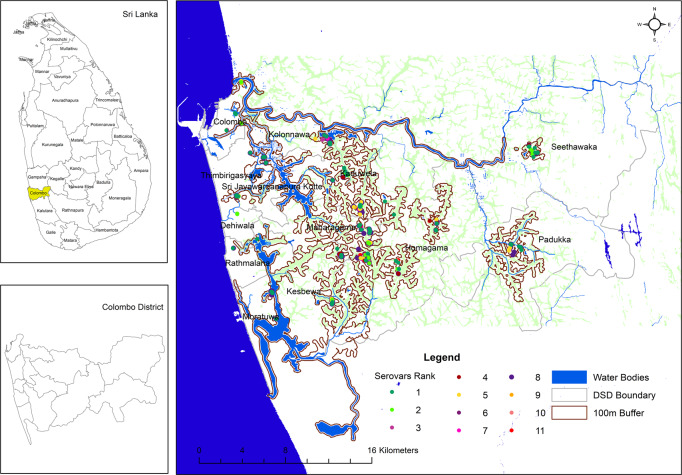
Pathogenic Serovar distribution among water bodies and paddy fields.Key to serovar numbers:1 –Australis, 2. Bankinang, 3 –Bataviae, 4 –Canicola, 5 –Ratnapura, 6—Hardjo, 7 –Icterohaemorrhagiae, 8 –Pyrogenes, 9 –Pomona, 10 –Hebdomadis, 11 –Cynopteri. Areas outlined in green indicates paddy fields and water tributaries. This image is licensed under the Creative Commons Attribution 4.0 International License (http://creativecommons.org/licenses/by/4.0/).